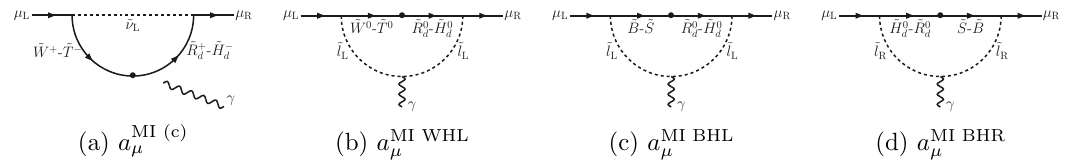
Figure 4. Mass-insertion diagrams corresponding to eq. (4.18). In these diagrams the charginos and neutralinos have de(cid:12)nite compositions as bino-singlino, wino-triplino, Higgsino-R-Higgsino states, and the o(cid:11)-diagonal entries of the mass matrices (2.25), (2.22) are inserted as vertices. In diagram (a), the photon can couple to all charged